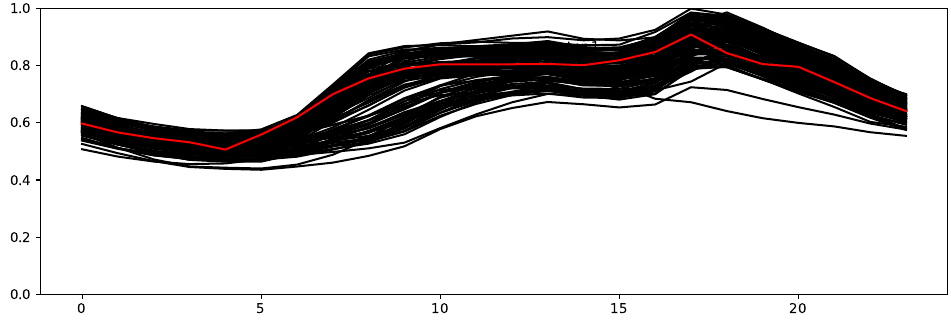
Figure A1. Season 1 demand data clustering.